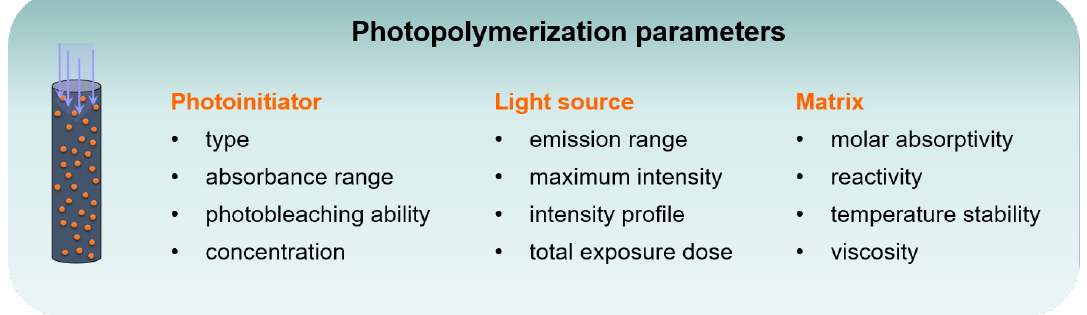
Figure 2. Key parameters for optimum curing (depth and photobleaching) in a light-induced radical polymerization.